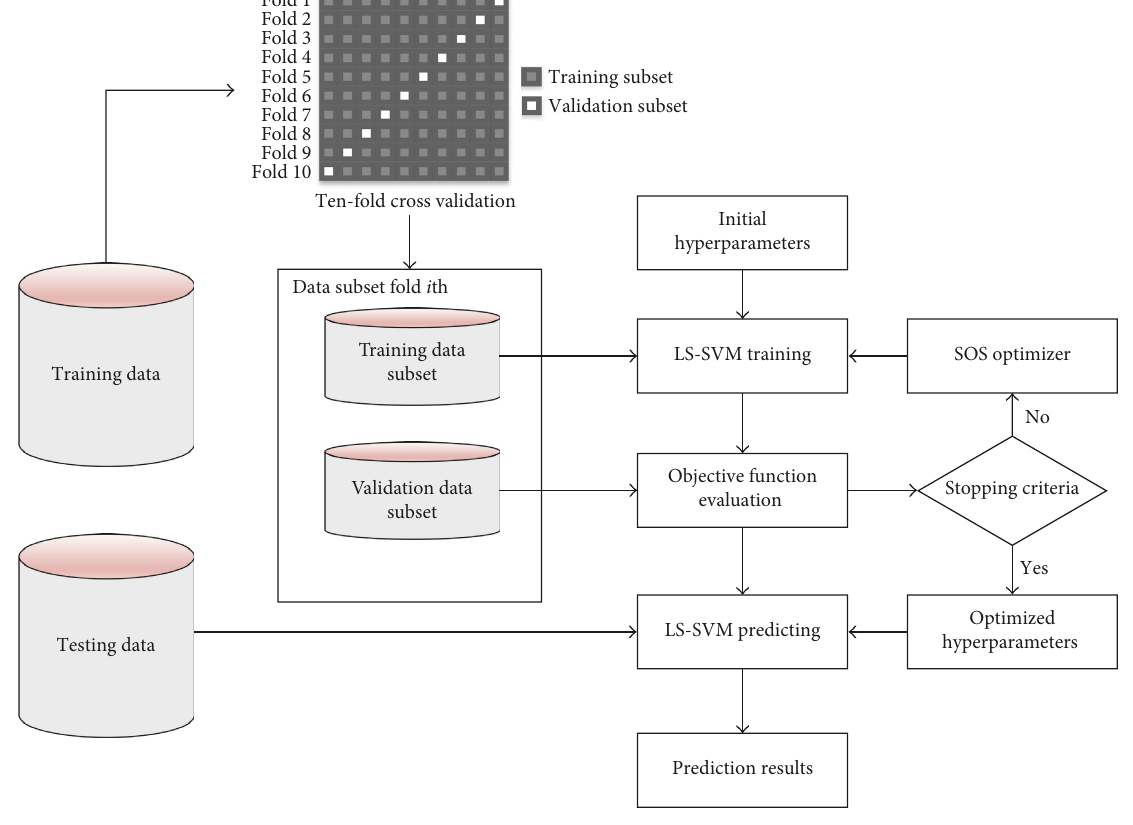
Figure 2: Framework of the ST-LSSVM method.